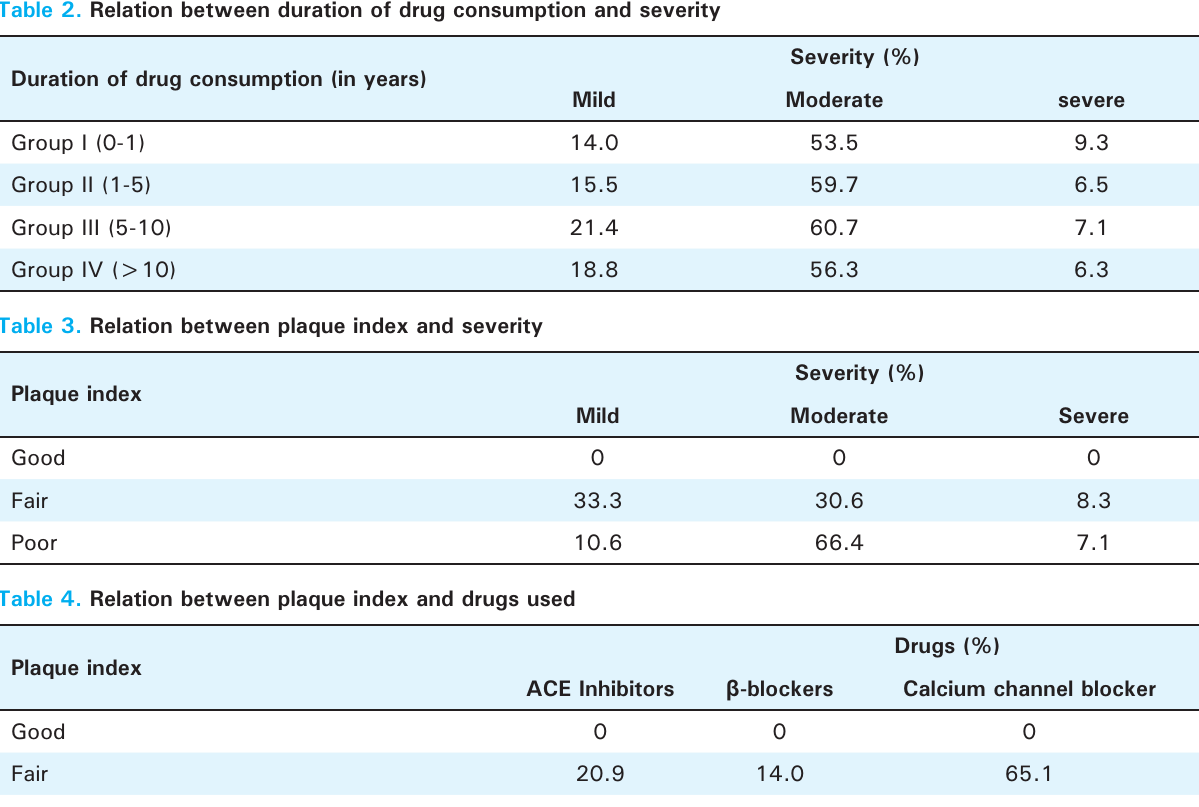
Table 2. Relation between duration of drug consumption and severity